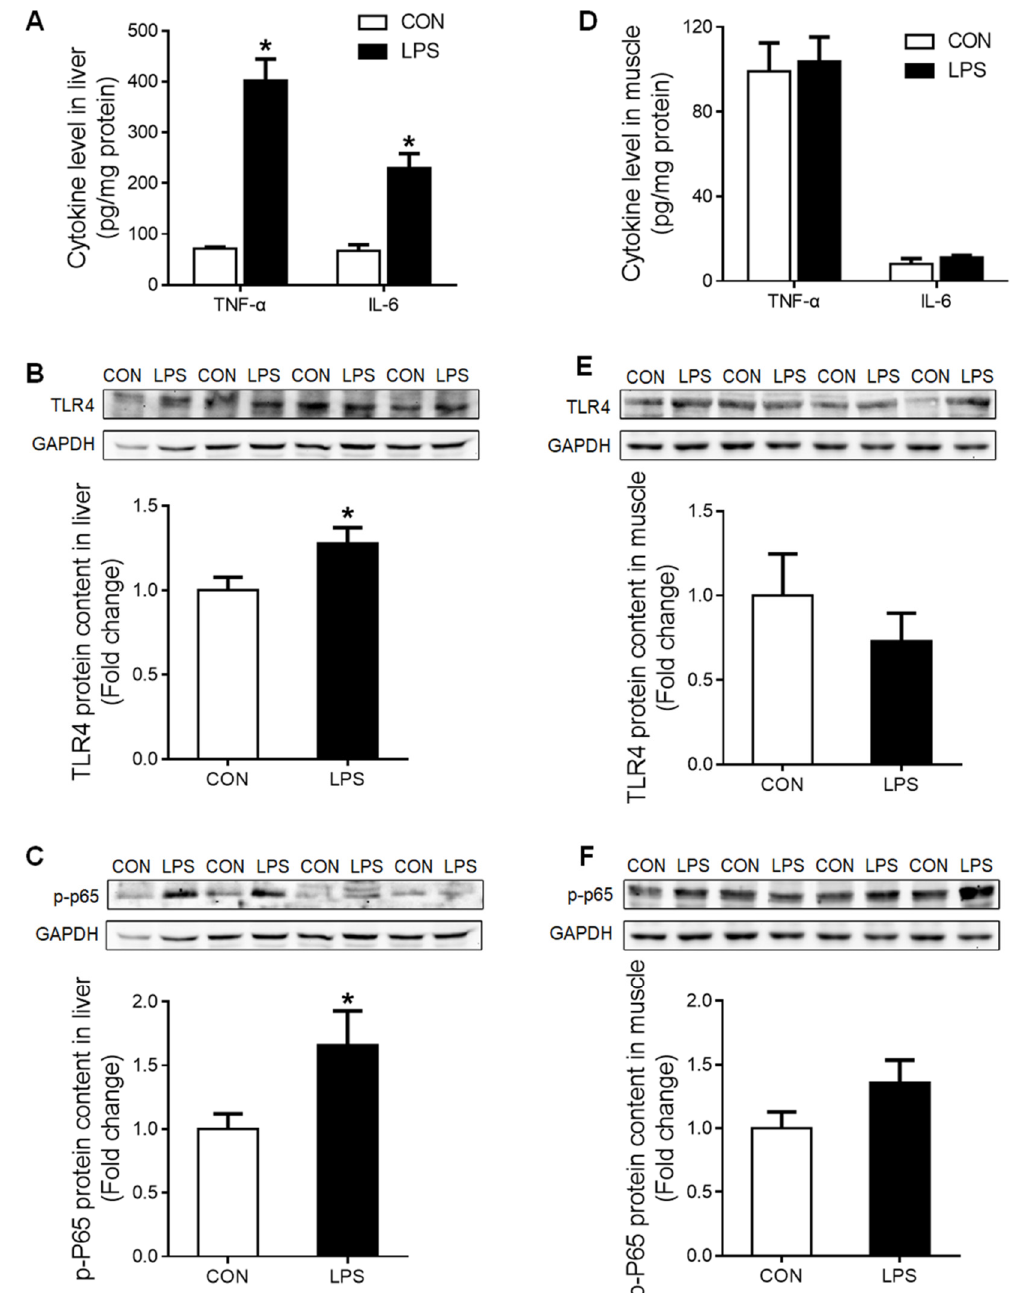
Figure 1. Inflammatory response in liver and muscle when treatment with LPS. ( A ) Liver cytokine levels of TNF- α and IL-6. ( B ) Western blot and densitometric analyses of TLR4 and GAPDH proteins in the liver. ( C ) Western blot and densitometric analyses of p-P65 and GAPDH proteins in the liver. ( D ) Muscle cytokine level of TNF- α and IL-6. ( E ) Western blot and densitometric analyses of TLR4 and GAPDH proteins in muscle. ( F ) Western blot and densitometric analyses of p-P65 and GAPDH proteins in muscle. Values were expressed as means ± SEM, n = 4 in each group, * p < 0.05.